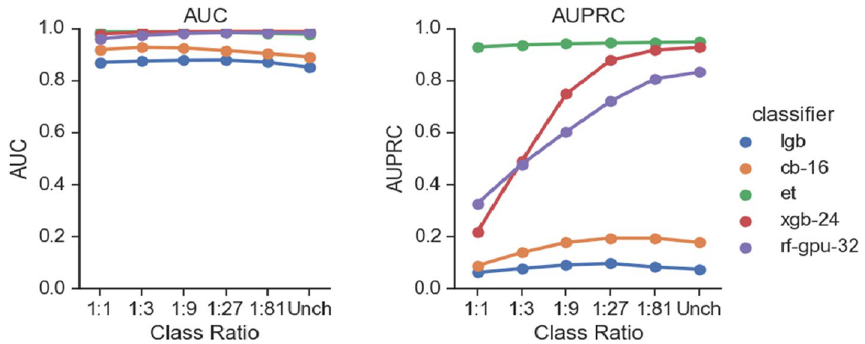
Fig. 1 DMEPOS Data: AUC Scores (left) and AUPRC scores (right)